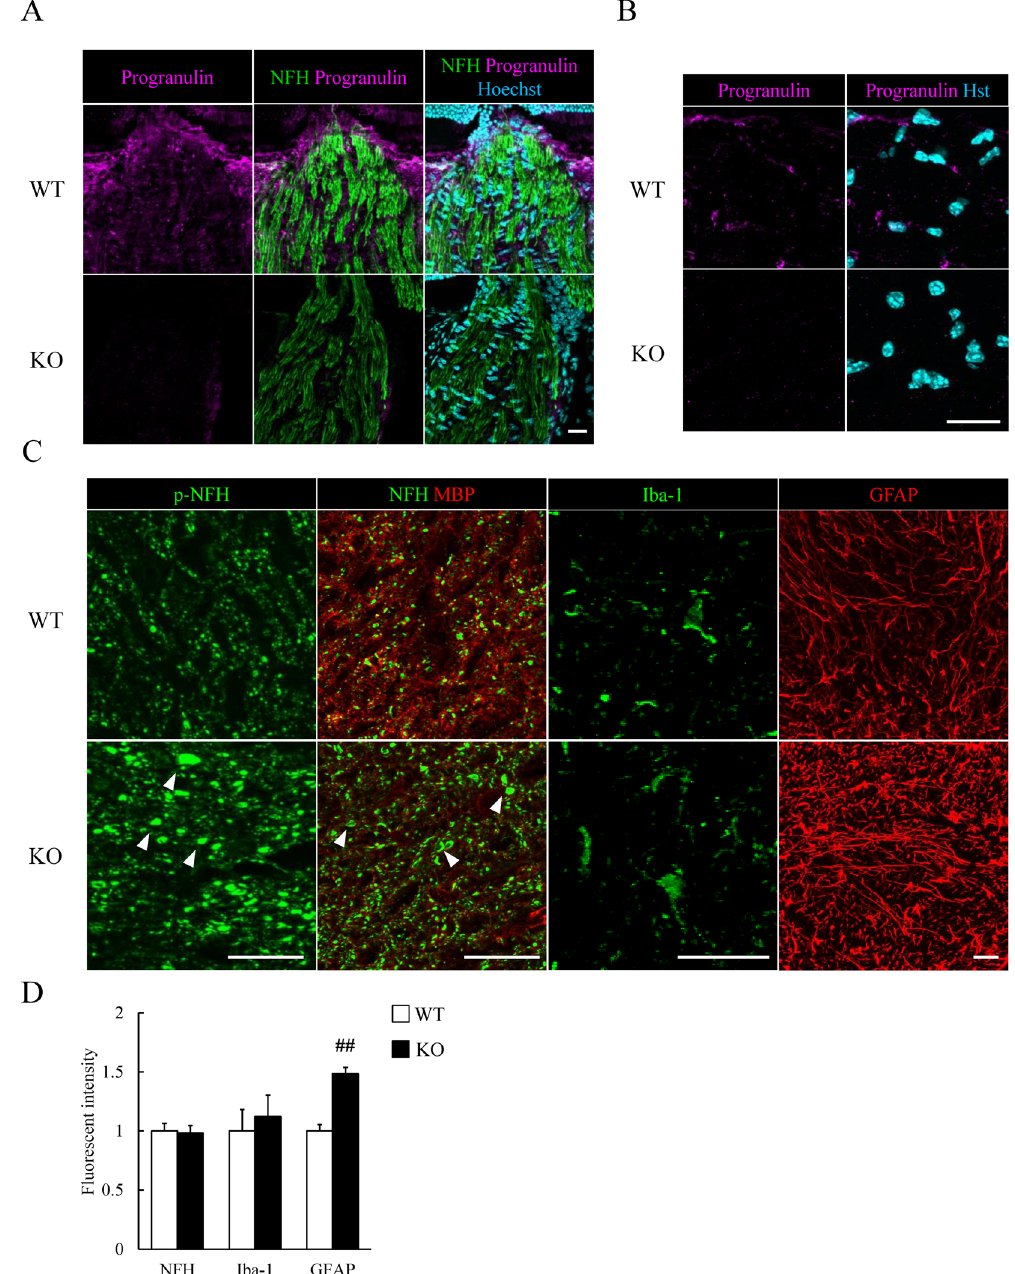
Figure 2. Changes of optic nerve in adult Grn − / − mice. ( A ) Progranulin expression (magenta) in WT optic nerve. Neurofilament heavy (NFH) stains the optic nerve (green). Progranulin expression is not present in optic nerve of KO mice. ( B ) Progranulin expression (magenta) in cross sections of WT and KO optic nerve. ( C ) Representative image showing phosphorylated neurofilament heavy (p-NFH), NFH, myelin basic protein (MBP), Iba-1 and GFAP. p-NFH and NFH are accumulated in Grn − / − mice. Iba-1 + microglia (green) is not changed in Grn − / − mice. GFAP + astrocytes (red) are activated in Grn − / − mice. ( D ) The fluorescent intensity of NFH and Iba-1 is not changed. GFAP expression is increased in Grn − / − mice. Data are the means ± S.E.M. ( n = 3). ## P < 0.01 vs. WT (Student’s t -test). WT: wild-type; KO: knock-out. Scale bar = 20 μ